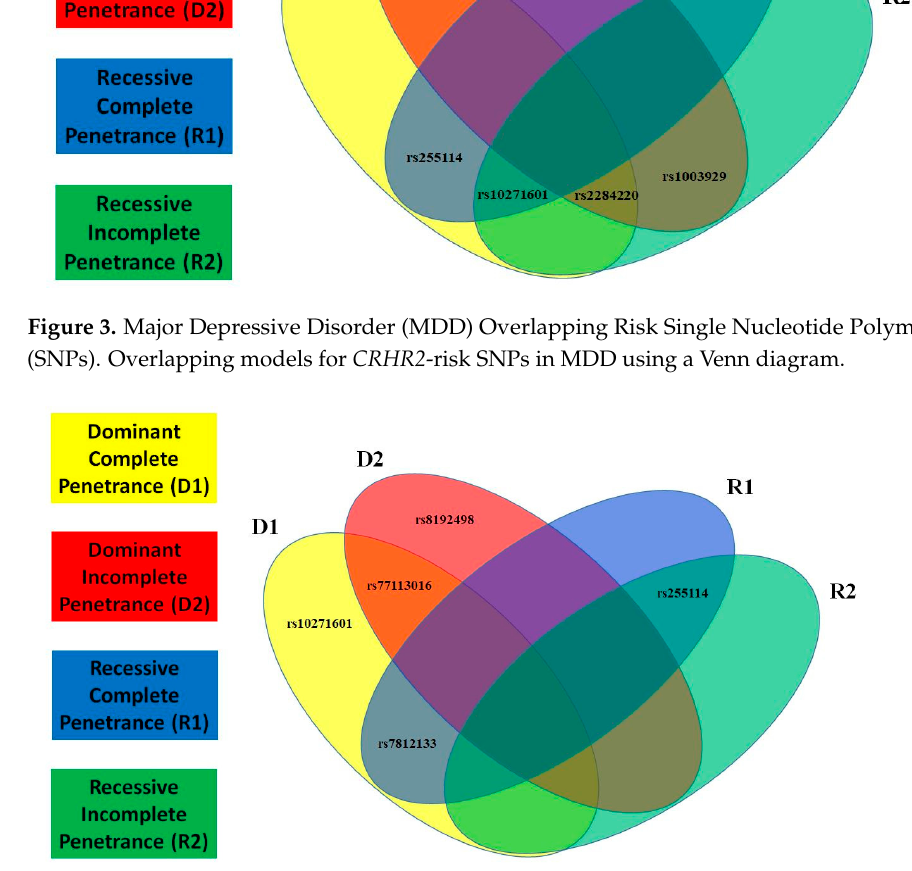
Figure 4. Type 2 Diabetes (T2D) Overlapping Risk Single Nucleotide Polymorphisms (SNPs). Overlapping models for CRHR2 -risk SNPs in T2D using a Venn diagram. Table 1. CRHR2 -Risk Single Nucleotide Polymorphisms (SNPs) for Major Depressive Disorder (MDD) and Type 2 Diabetes (T2D).